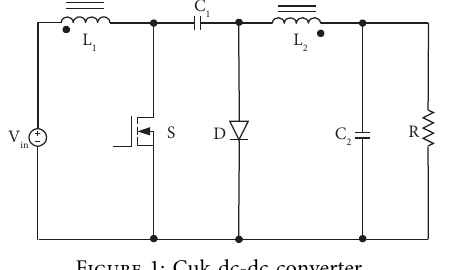
Figure 1: Cuk dc-dc